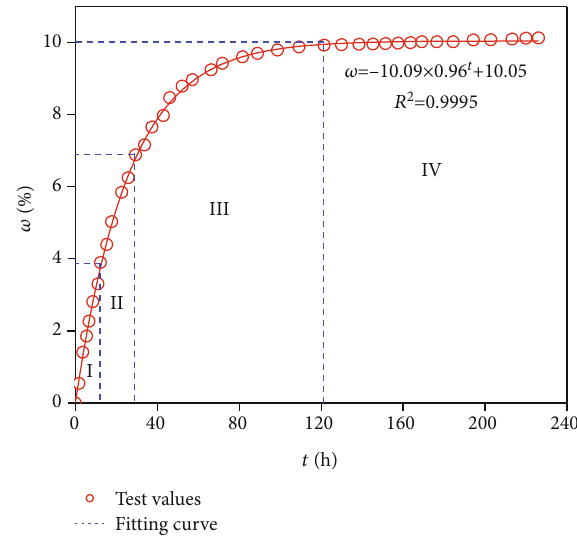
Figure 3: Curve of water content change with soaking